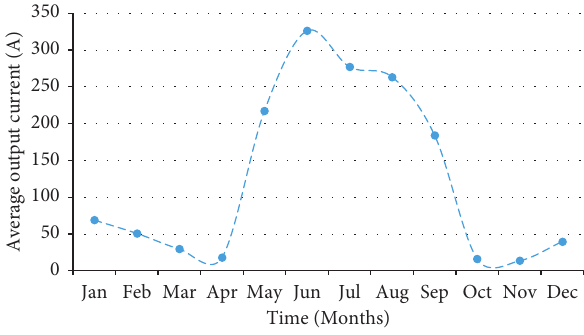
Figure 3: Variation of current output over the year